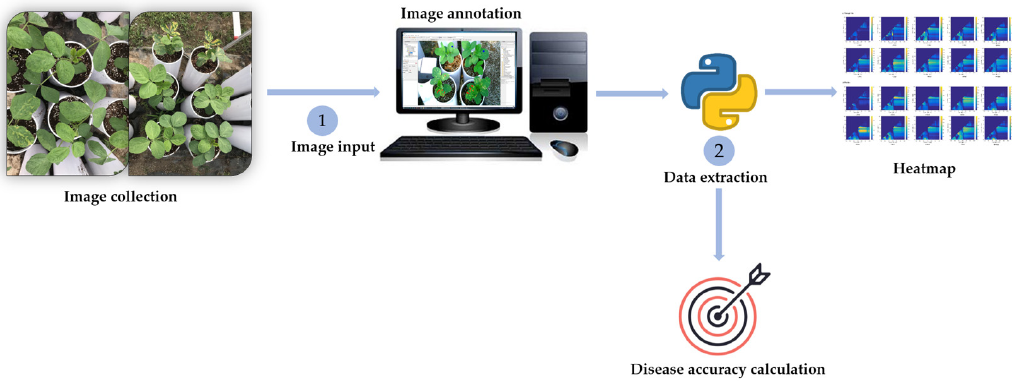
Figure 5. Flow chart of image processing and analysis. The flow chart represents image acquisition followed by image annotation using ENVI software, extraction of annotated data, and analysis using the Python algorithm to accurately access the healthy and diseased plants.